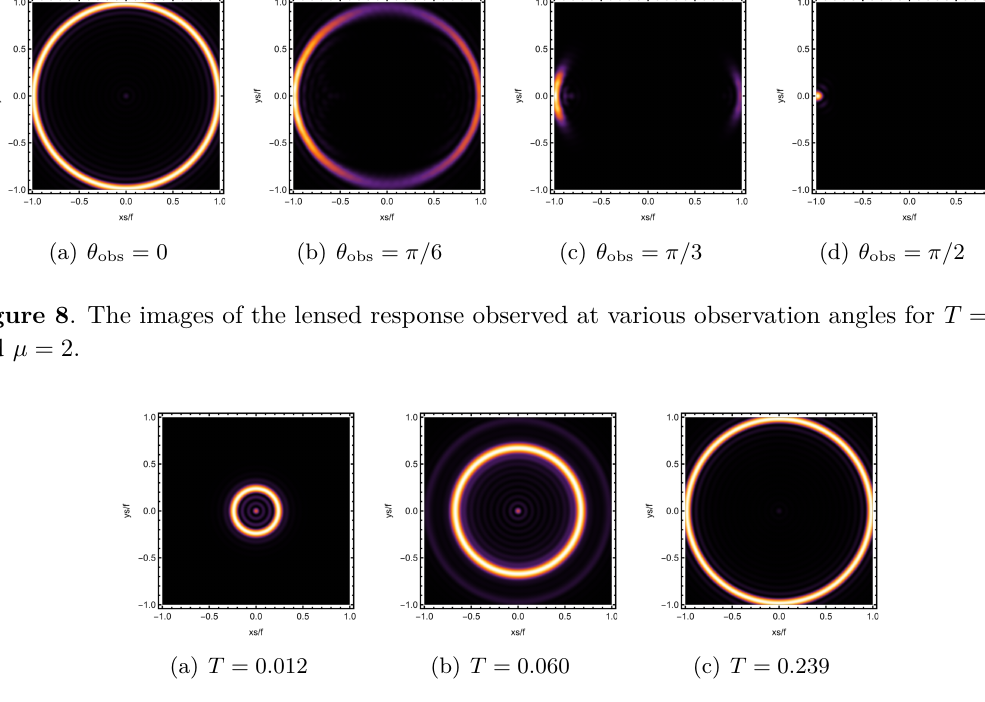
Figure 9 . The variation of the image of the lensed response with the temperature at the observation angle θ obs = 0 for the fixed chemical potential µ = 2